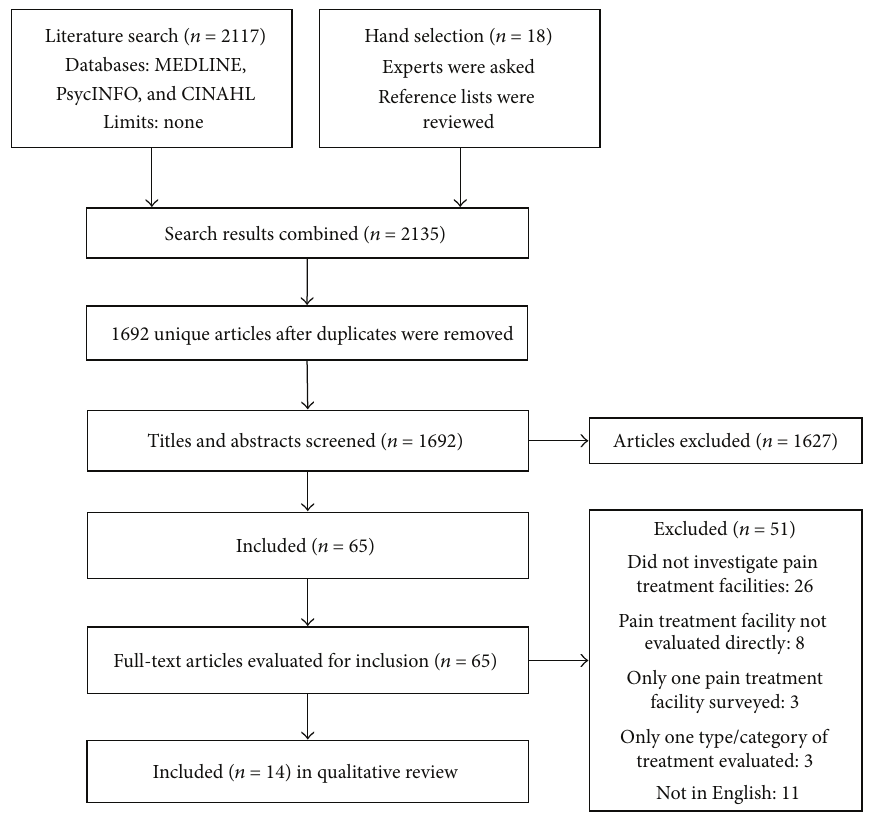
Figure 1: Flow diagram of study